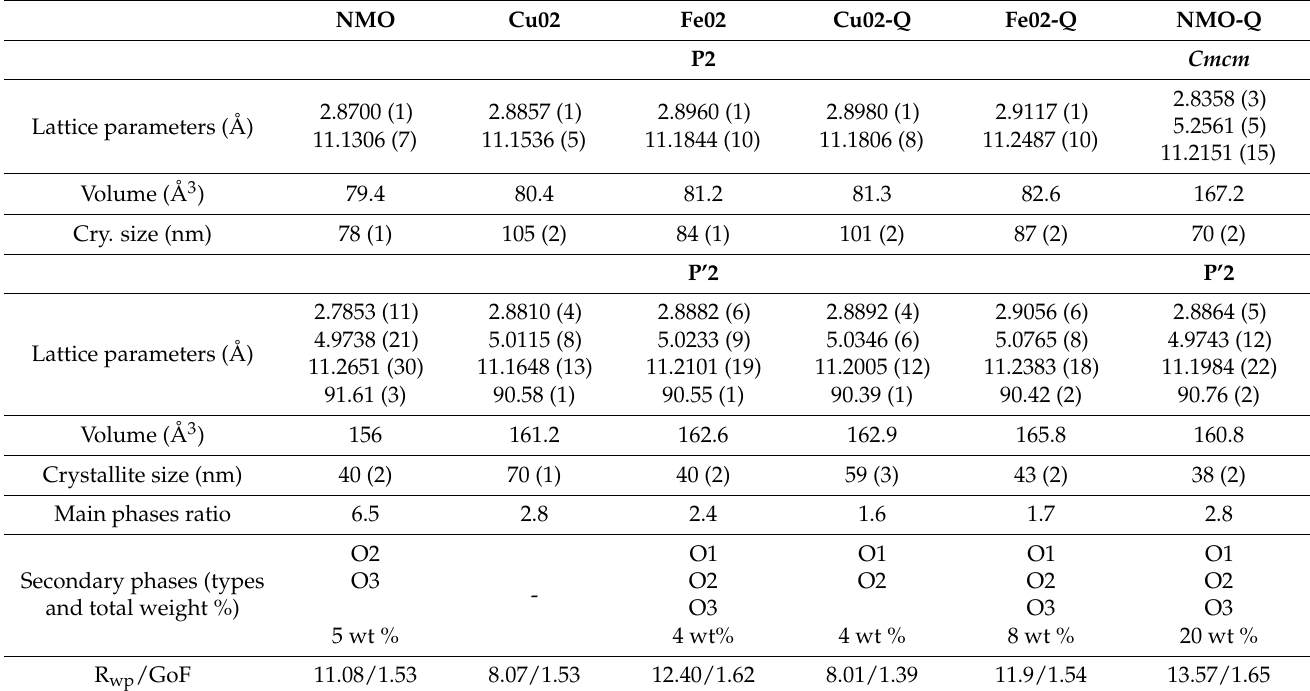
Table 1. Main structural parameters, secondary phase amounts, and agreement indices (R wp and GoF) obtained from Rietveld refinements on undoped and doped sample patterns from both the slow-cooling and quenching